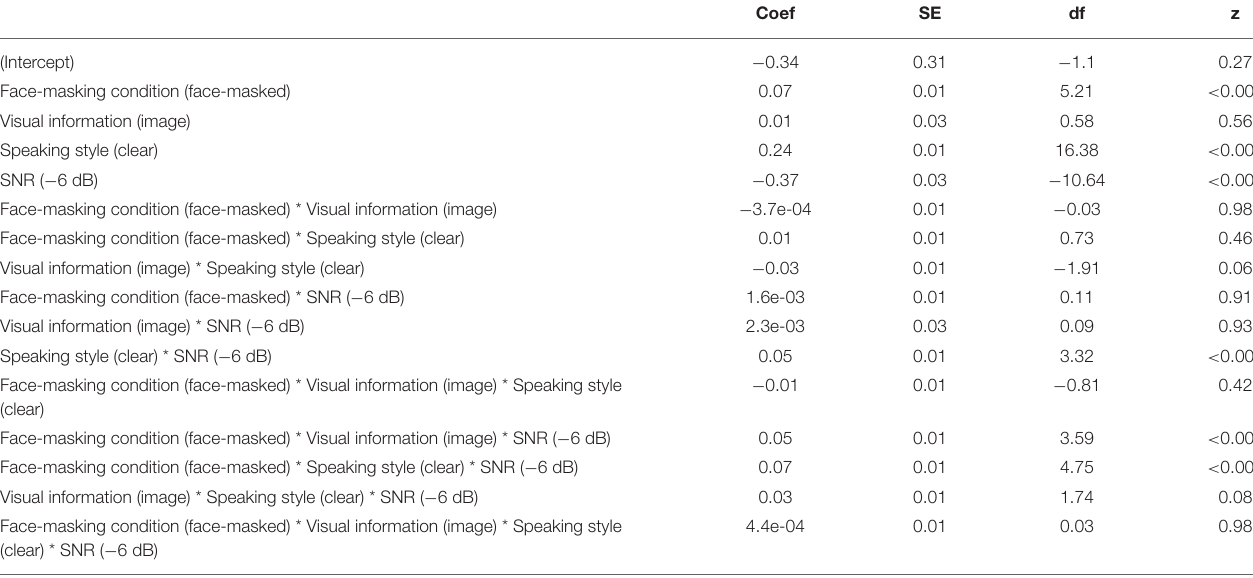
TABLE 3 | Summary statistics for the linear mixed effects model of the combined − 3 and − 6 dB